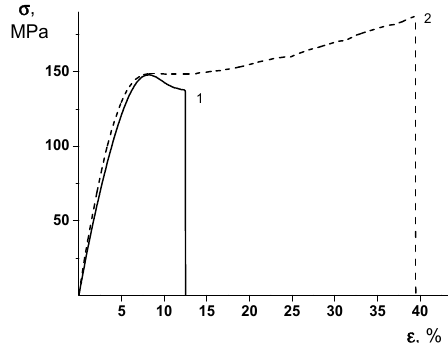
Figure 5. Stress–strain curves of (1) PEA and (2) PEA–Cu(I) membranes.